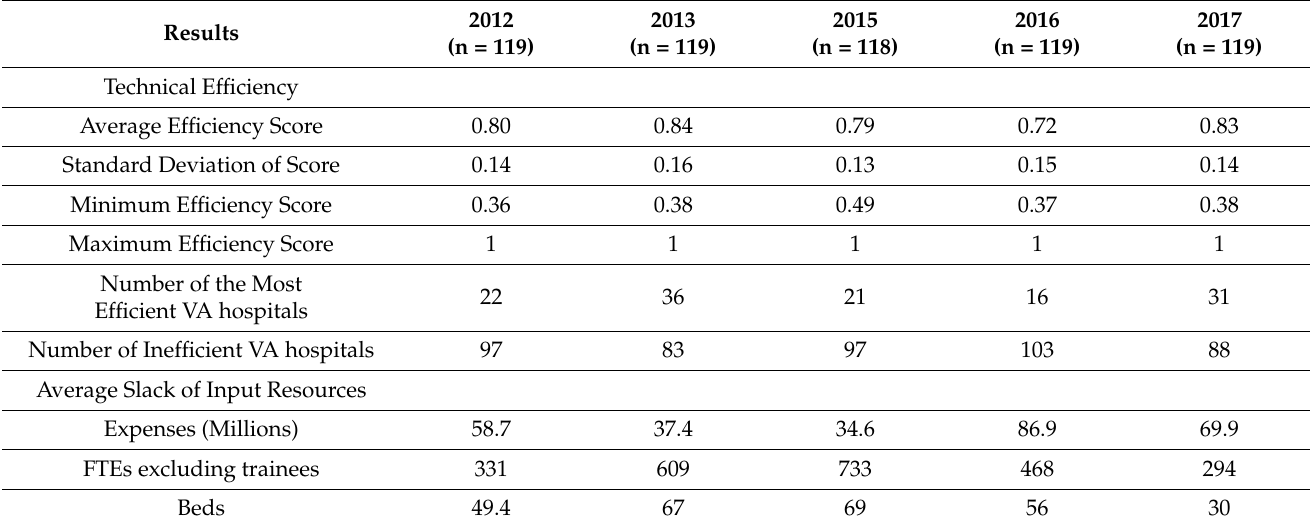
Table 3. Technical Efficiency Scores and Input Slack Analysis.